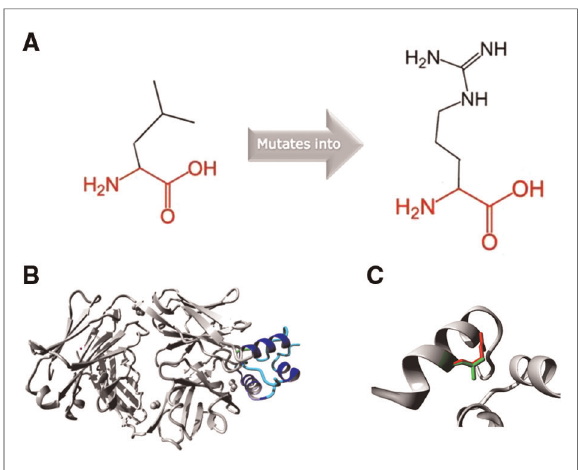
FIGURE 2 ( A ) Schematic structure of the original and the mutant amino acid. ( B ) Overview of the protein in ribbon-presentation. The protein is coloured by element; α -helix=blue and random coil=cyan. ( C ) Close-up of the mutation. The protein is coloured grey, the side chains of the wild-type (green) and the mutant residue